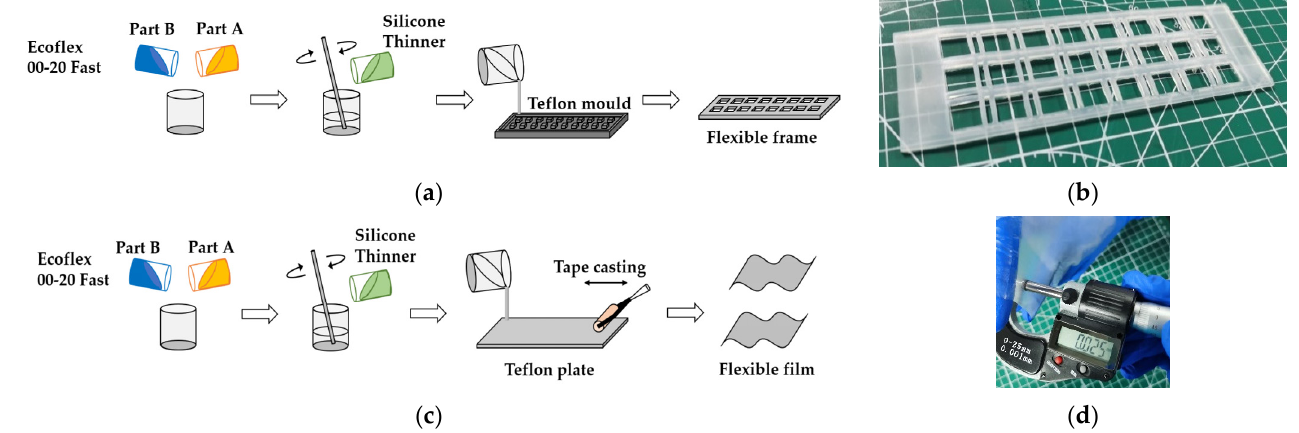
Figure 2. ( a ) Preparation process of the flexible Ecoflex frame; ( b ) the photo of a finished flexible frame; ( c ) manufacturing process of the flexible Ecoflex film; ( d ) the photo of a finished flexible film with thickness of ~25 μ m.